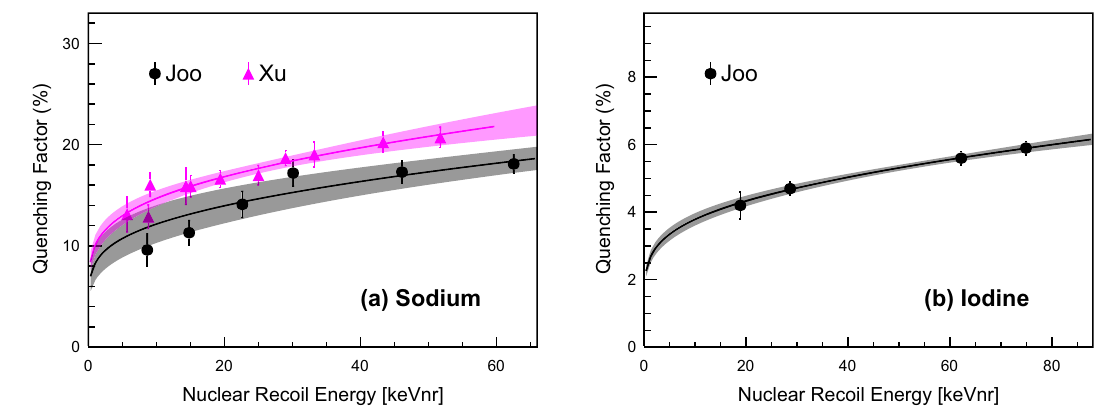
Fig. 25 Measured quenching factors by Joo et al. [84] (black circles) and Xu et al. [85] (purple triangles) for sodium ( a ) and iodine ( b ) are fitted with the modified Lindhard model